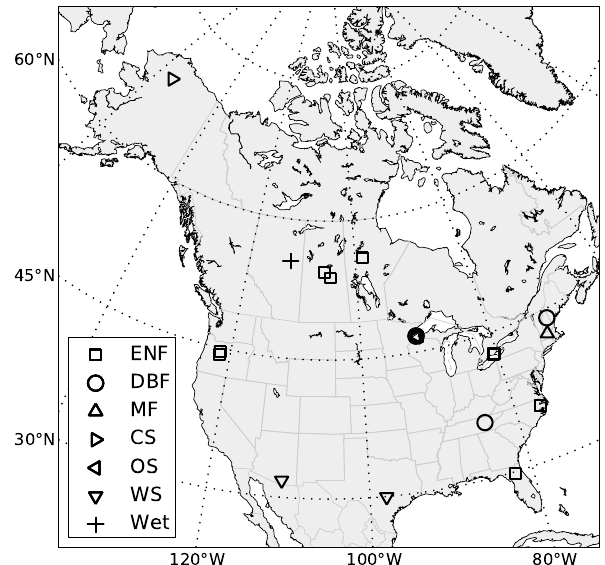
Fig. 2. The 27 eddy covariance flux tower “cross-validation” sites from the 2007 FluxNet synthesis dataset that were not used for VPRM parameterization or for VPRM NEE error covariance pa- rameter estimation. Plant functional type abbreviations: ENF – ev- ergreen needleleaf forest, DBF – deciduous broadleaf forest, MF